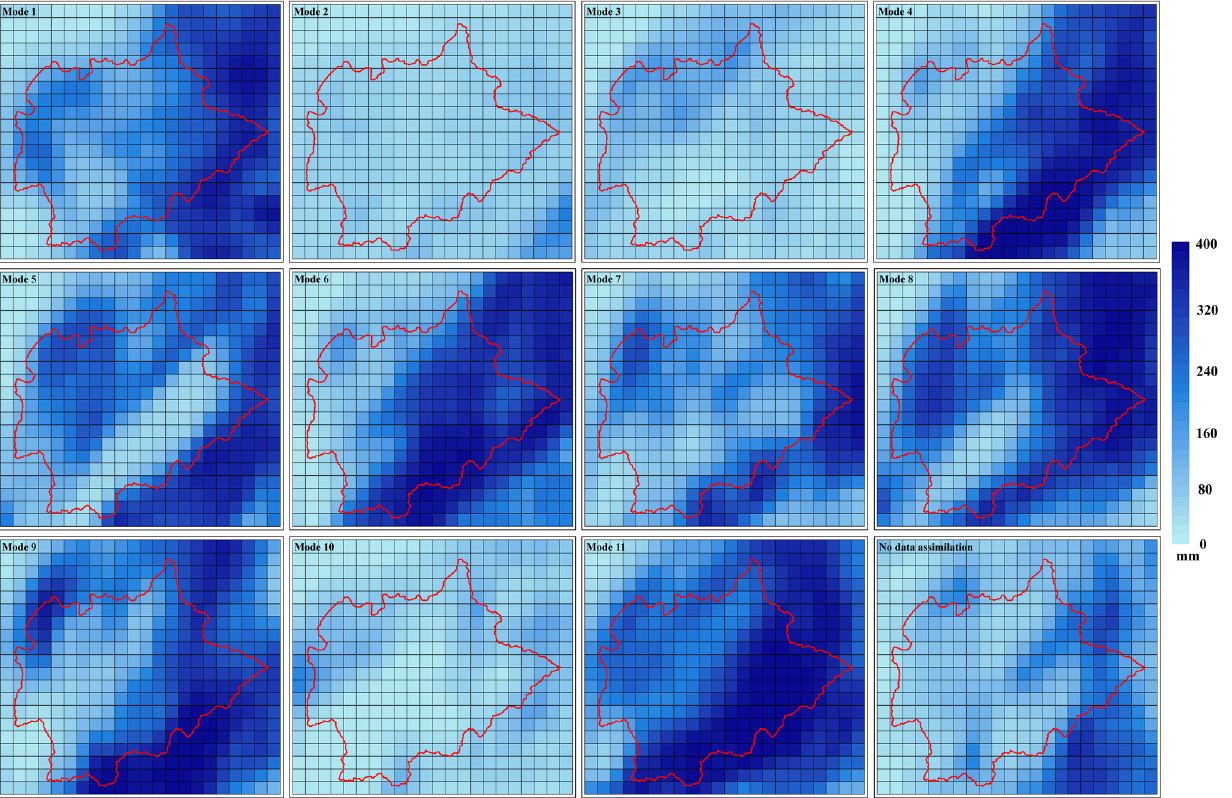
Figure 6. Spatial distributions of the forecasted 24h rainfall accumulations from different data assimilation